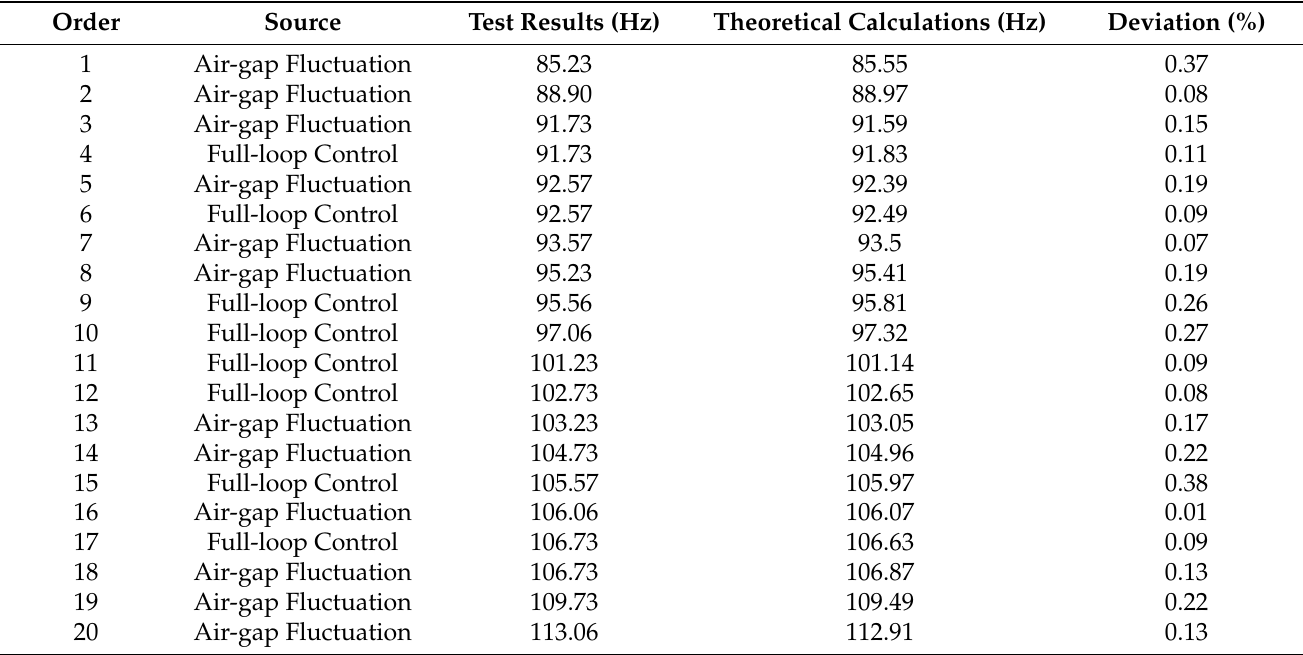
Table 5. The coupling thrust force caused by the second-order cutting force.